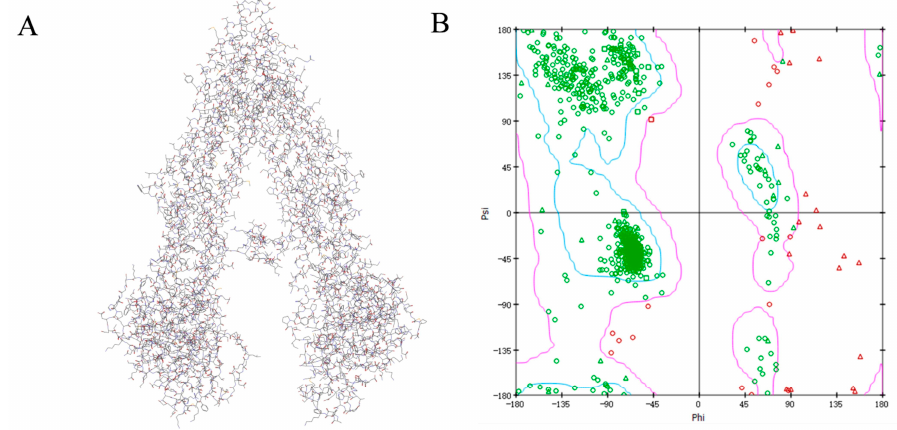
Figure 5. The homology modelled structure ( A ) and Ramachandran map ( B ) of Human MDR1. PDF Total Energy and DOPE Score of P08183.3.M0007 are 7361.354 and − 137,194.672, respectively. Profile-3D was used for further evaluation by comparing the identity of the 3D homology model with Ramachandran Plot represents the φ (phi) and ψ (psi) torsion angles of a residue, indicating that